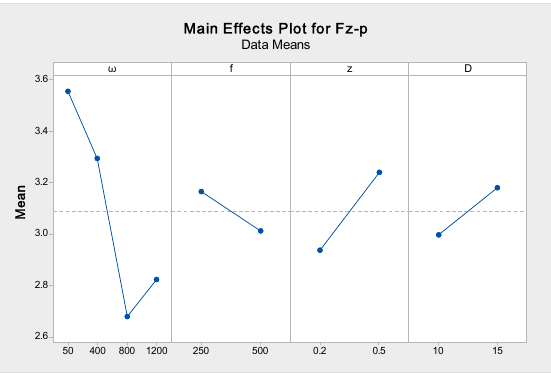
Figure 18. The main effects plot for the F z-p .